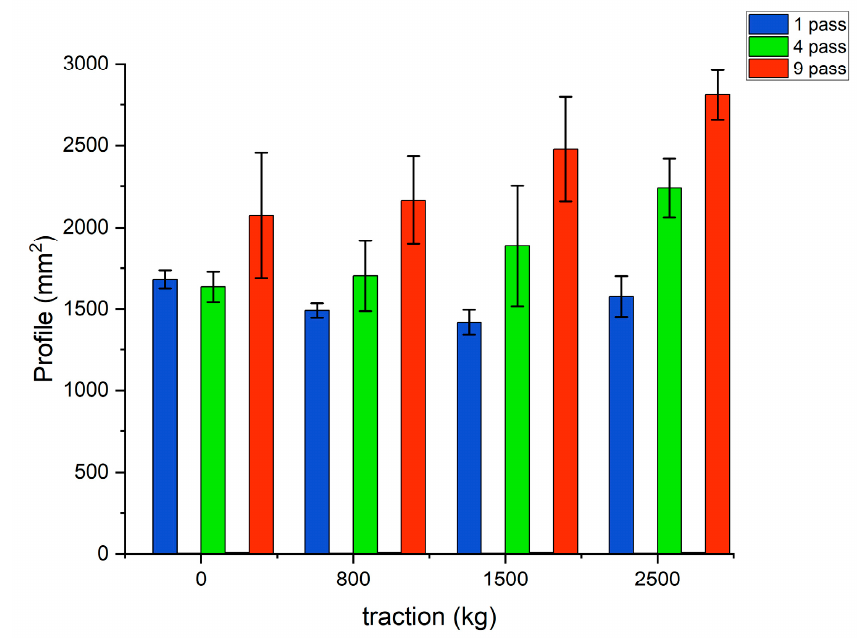
Figure 15. Soil profile meter after passes of different traction conditions.